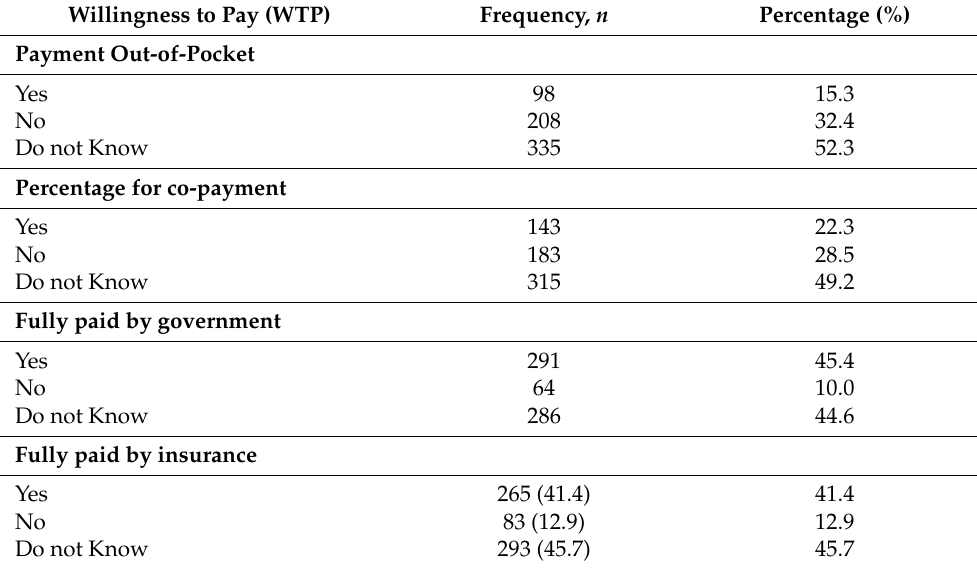
Table 1. Willingness to pay for cancer genetic test ( n =